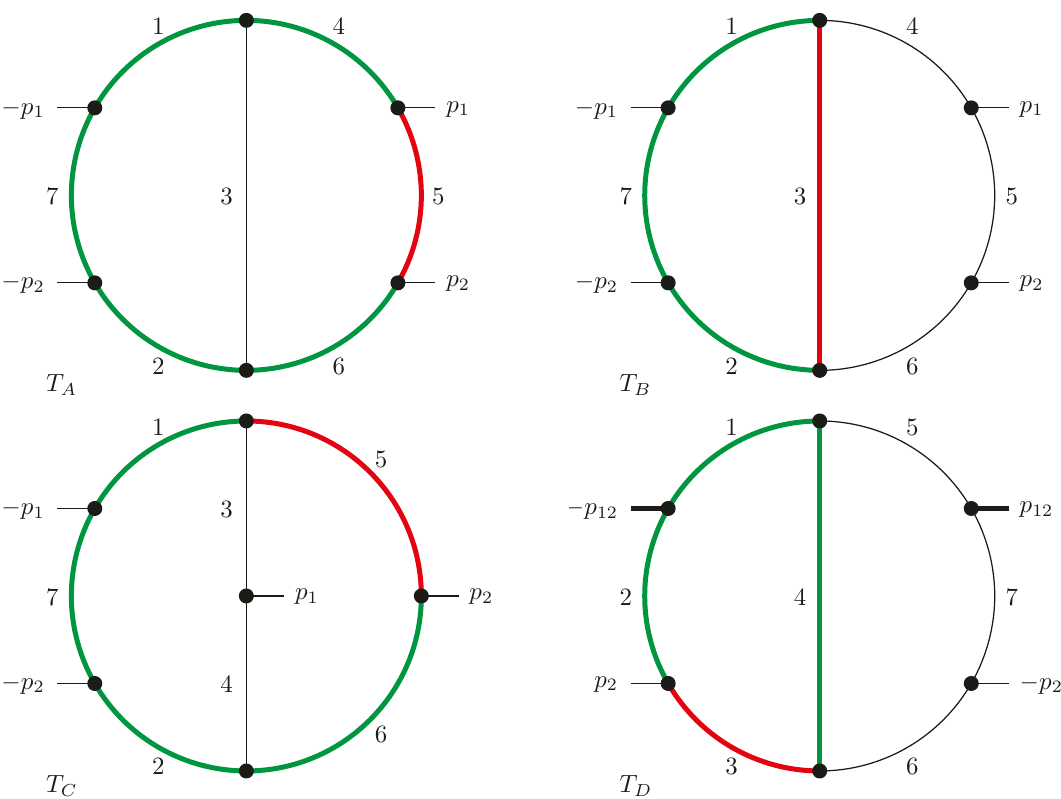
Figure 2 . Auxiliary diagrams for the two planar vertex corrections, the non-planar vertex cor- rection and topology D . The internal masses of the propagators are encoded by the colour of the propagators: massless (black), m t (green), m W